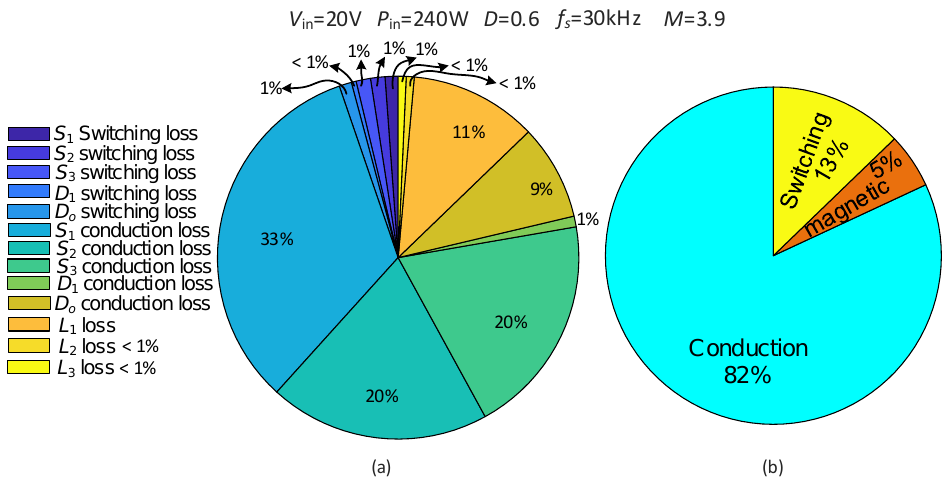
Figure 16. The switching and conduction losses distribution—( a ) element losses distribution; ( b ) total losses distribution.